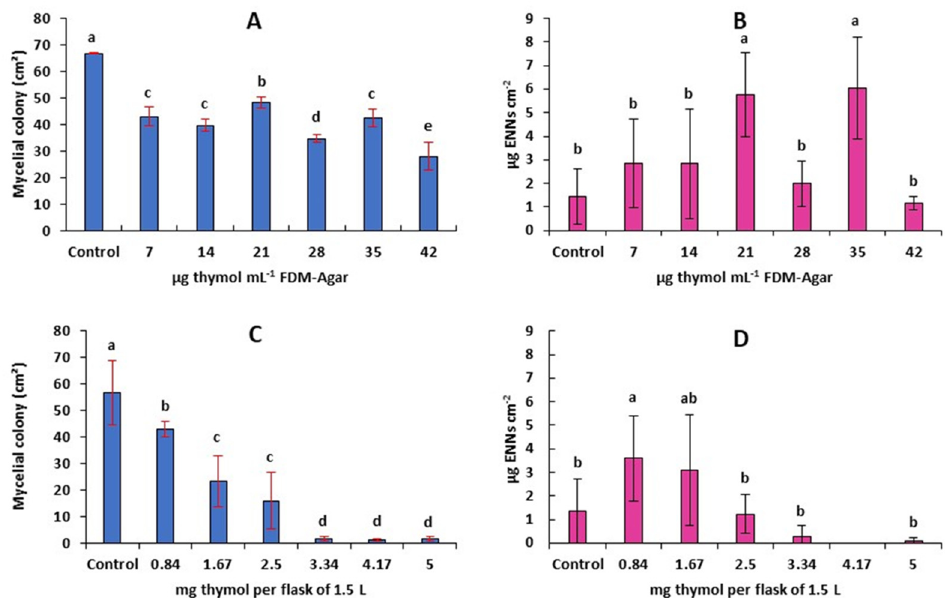
Figure 5. Effect of thymol on the mycelial growth rate ( A , C ) and production of ENNs ( B , D ) by F. avenaceum . Thymol was either diluted in the culture medium ( A , B ) or use as a fumigant ( C , D ). Values are means of 6 replicates. Error bars are ± standard deviation. Means with the same lowercase letter are not significantly different ( p < 0.05).